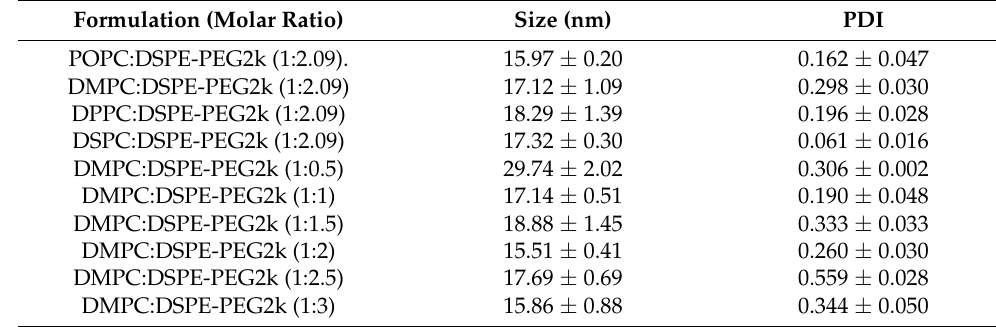
Table 1. Average particle size of different micelles measured by DLS ( n = 3, mean ± SD). Micelles were diluted to a 2 mM concentration with PBS and size was determined using Malvern Zetasizer Nano